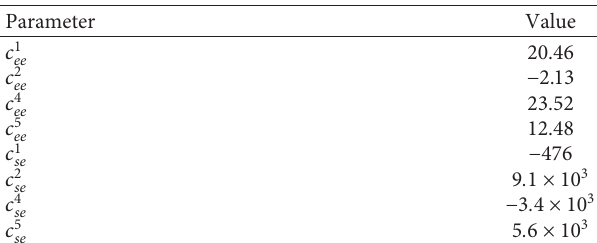
Table 3: The result of PSO algorithm of the optimized values of the disturbance rejection connections.